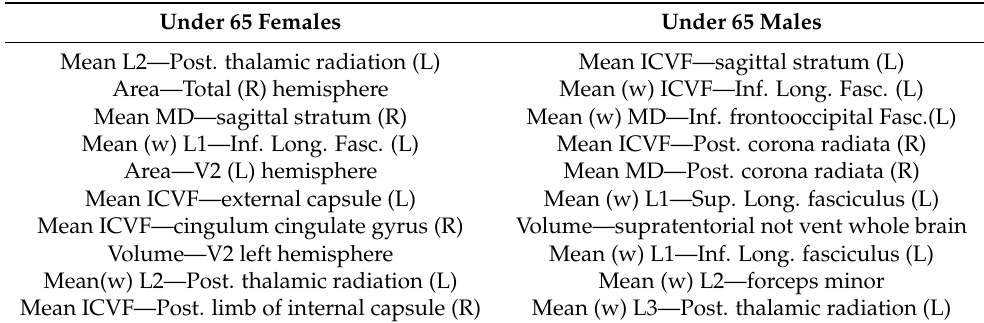
Table 4. Top 10 image-derived phenotypes for classifying the UKB participants into APOE4 carriers or APOE 3/3 controls in males and females aged under 65 years. Under 65 Females Under 65 Males Mean L2—Post. thalamic radiation (L) Area—Total (R) hemisphere